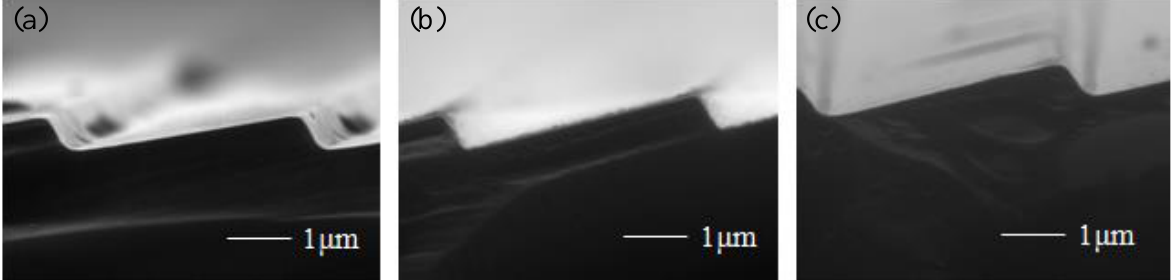
Figure 11. Grating grooves prepared under different oxidation time of ( a ) 1 h; ( b ) 2 h; and ( c ) 4 h. The grating profile measured by the optical profiler is shown in Figure 12a. The actual blaze angle was 7.4°, which had an offset of 1.4° to the designed value. This deviation mainly came from two sources. One was the cutting angle error of the tilted (111) substrate,